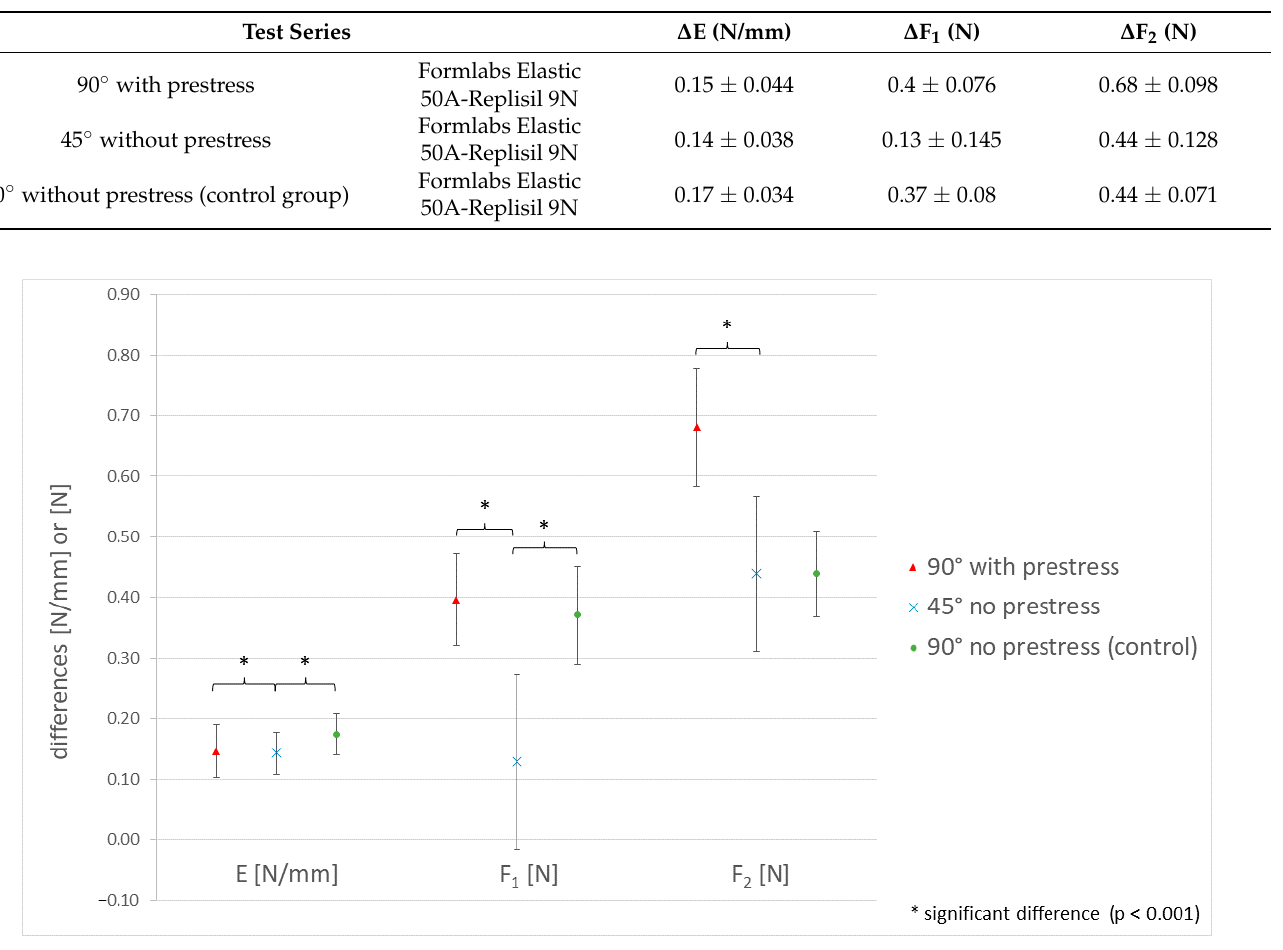
Figure 8. Visualization of the measured means and standard deviations of all three parameters, two materials and three groups. The slope E is in N/mm. The first force maximum F 1 and the following maximum force F 2 are in N. Table 3. Mean test results of the differences of the three parameters ∆ E, ∆ F 1 and ∆ F 2 with standard deviations. The gradient of the linear graph part ∆ E is in N/mm. The first force maximum ∆ F 1 and the following maximum force ∆ F 2 are in N.